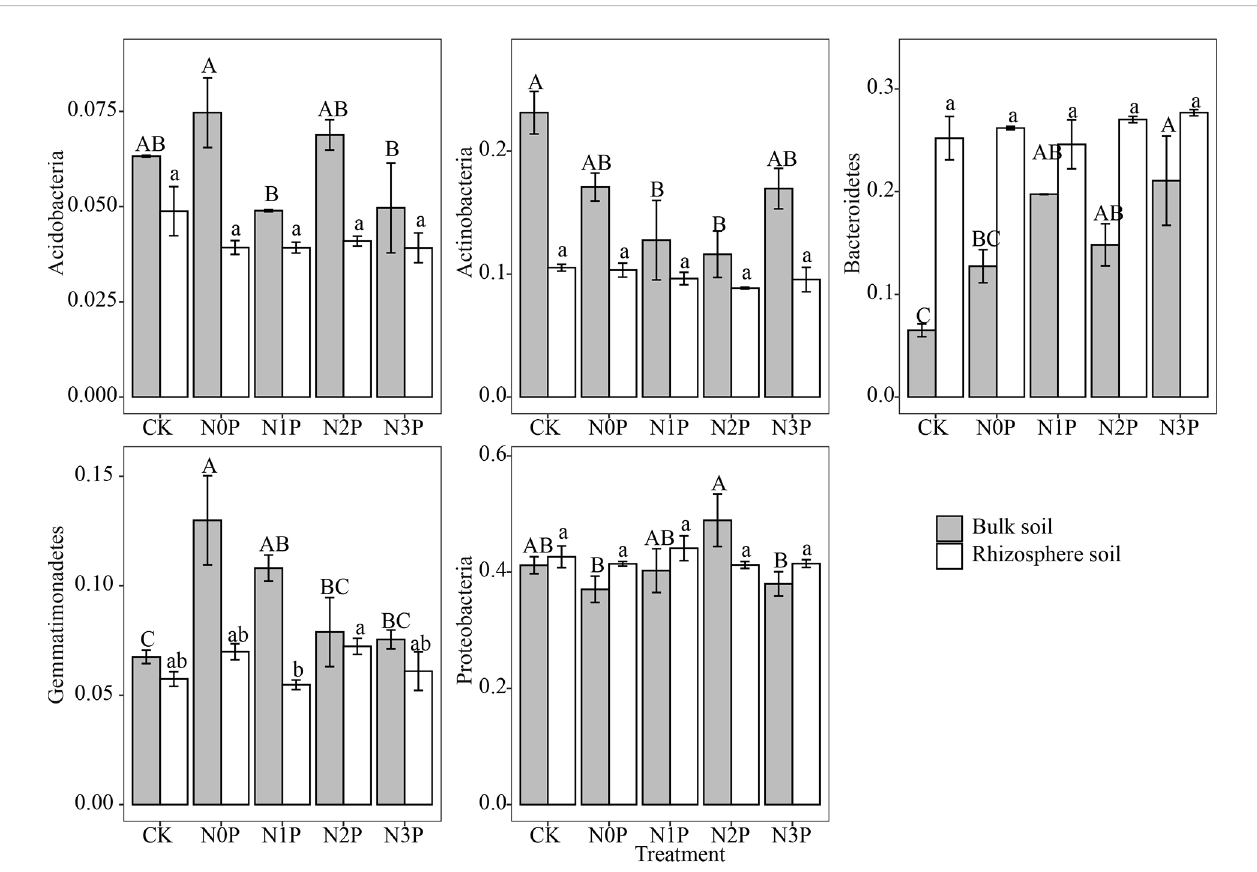
FIGURE 3 The relative abundance of dominant bacterial phyla in the rhizosphere and bulk soil of S. salsa at different N-P addition ratio treatments. Different capital letters indicate that the difference among N-P addition ratio treatments in bulk soil is signi fi cant (P<0.05) and different lowercase letters indicate that the difference among N-P addition ratio treatments in rhizosphere soil is signi fi cant